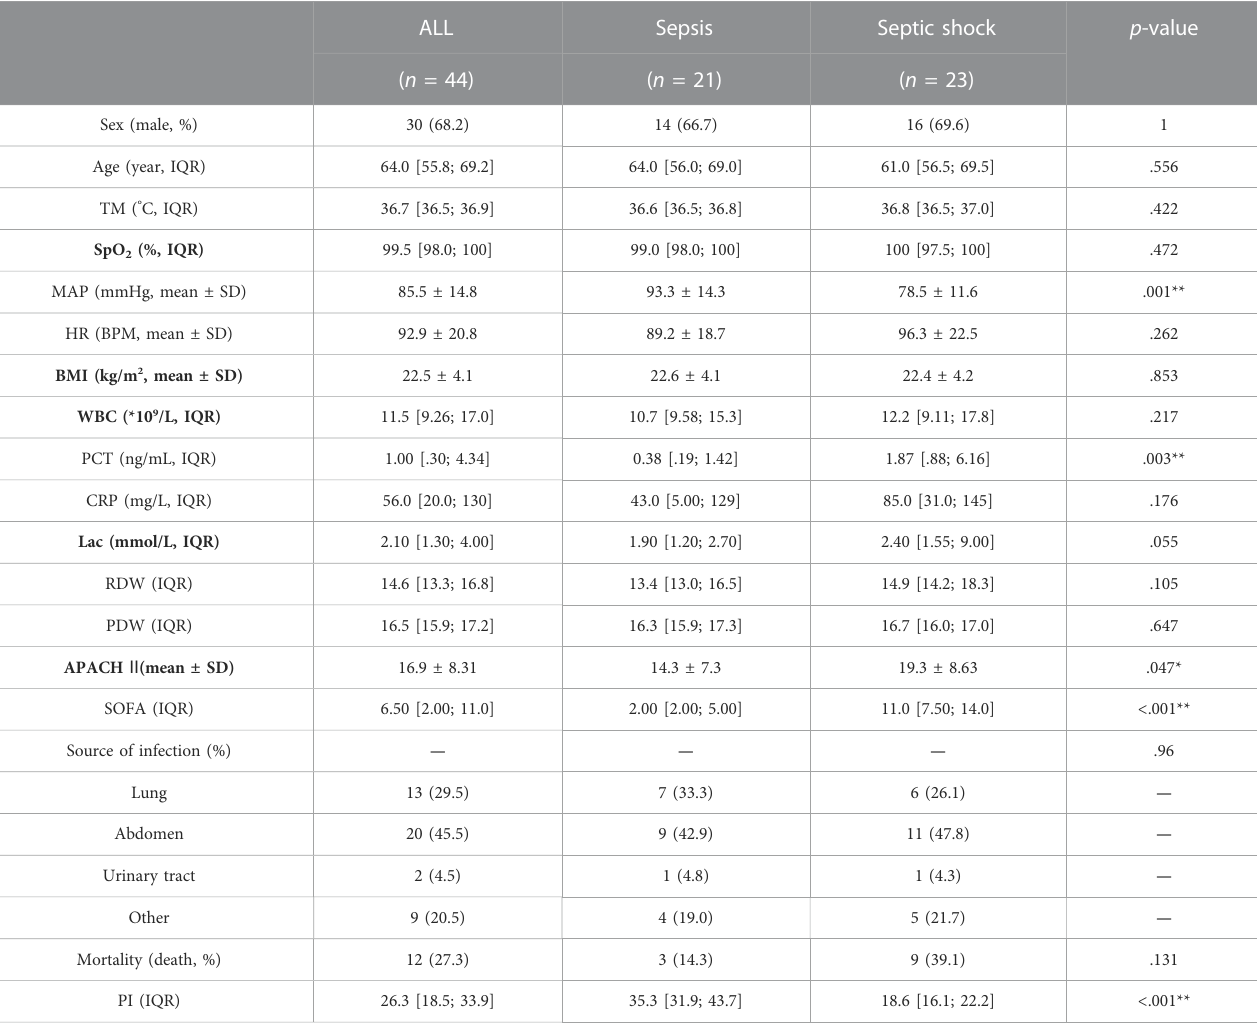
TABLE 1 p-value for baseline data between the sepsis and septic shock group.